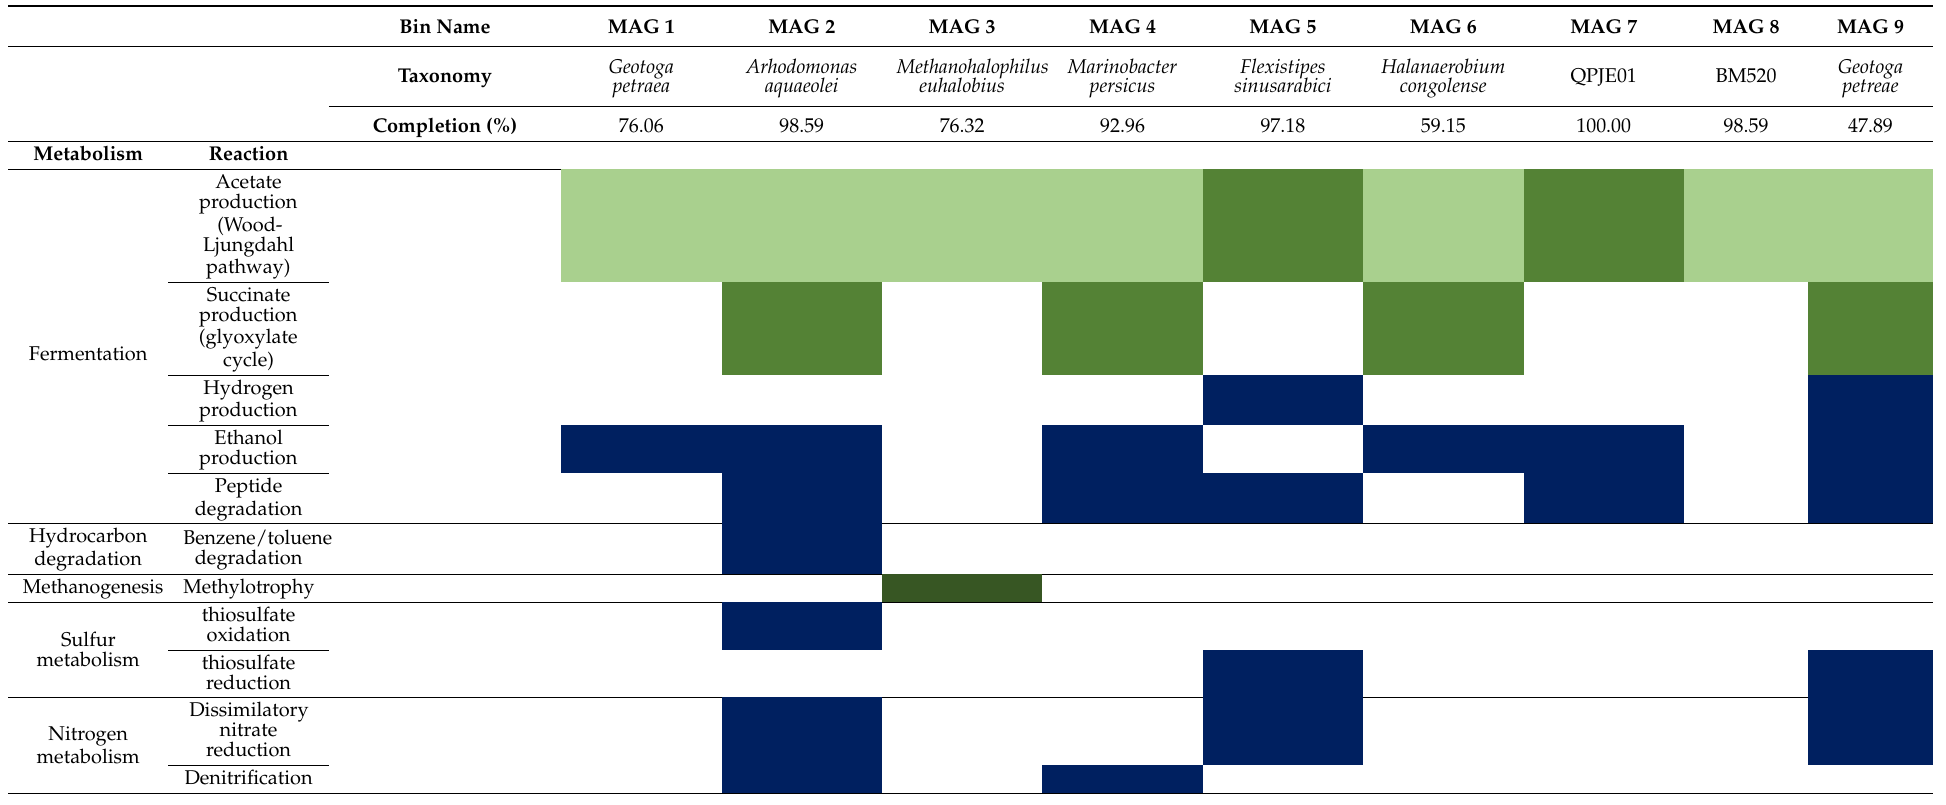
Table 2. Summary of metabolic potential for reconstructed MAGs derived from oil reservoir formation